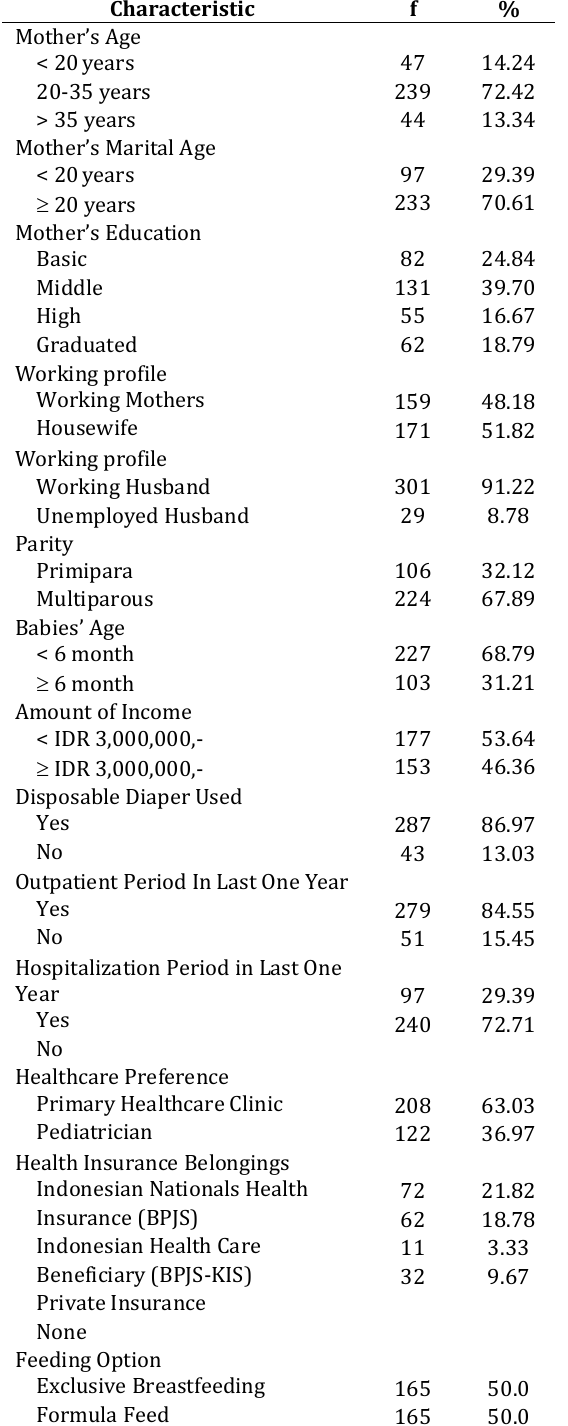
Table 1. Subject Characteristic (n=330)